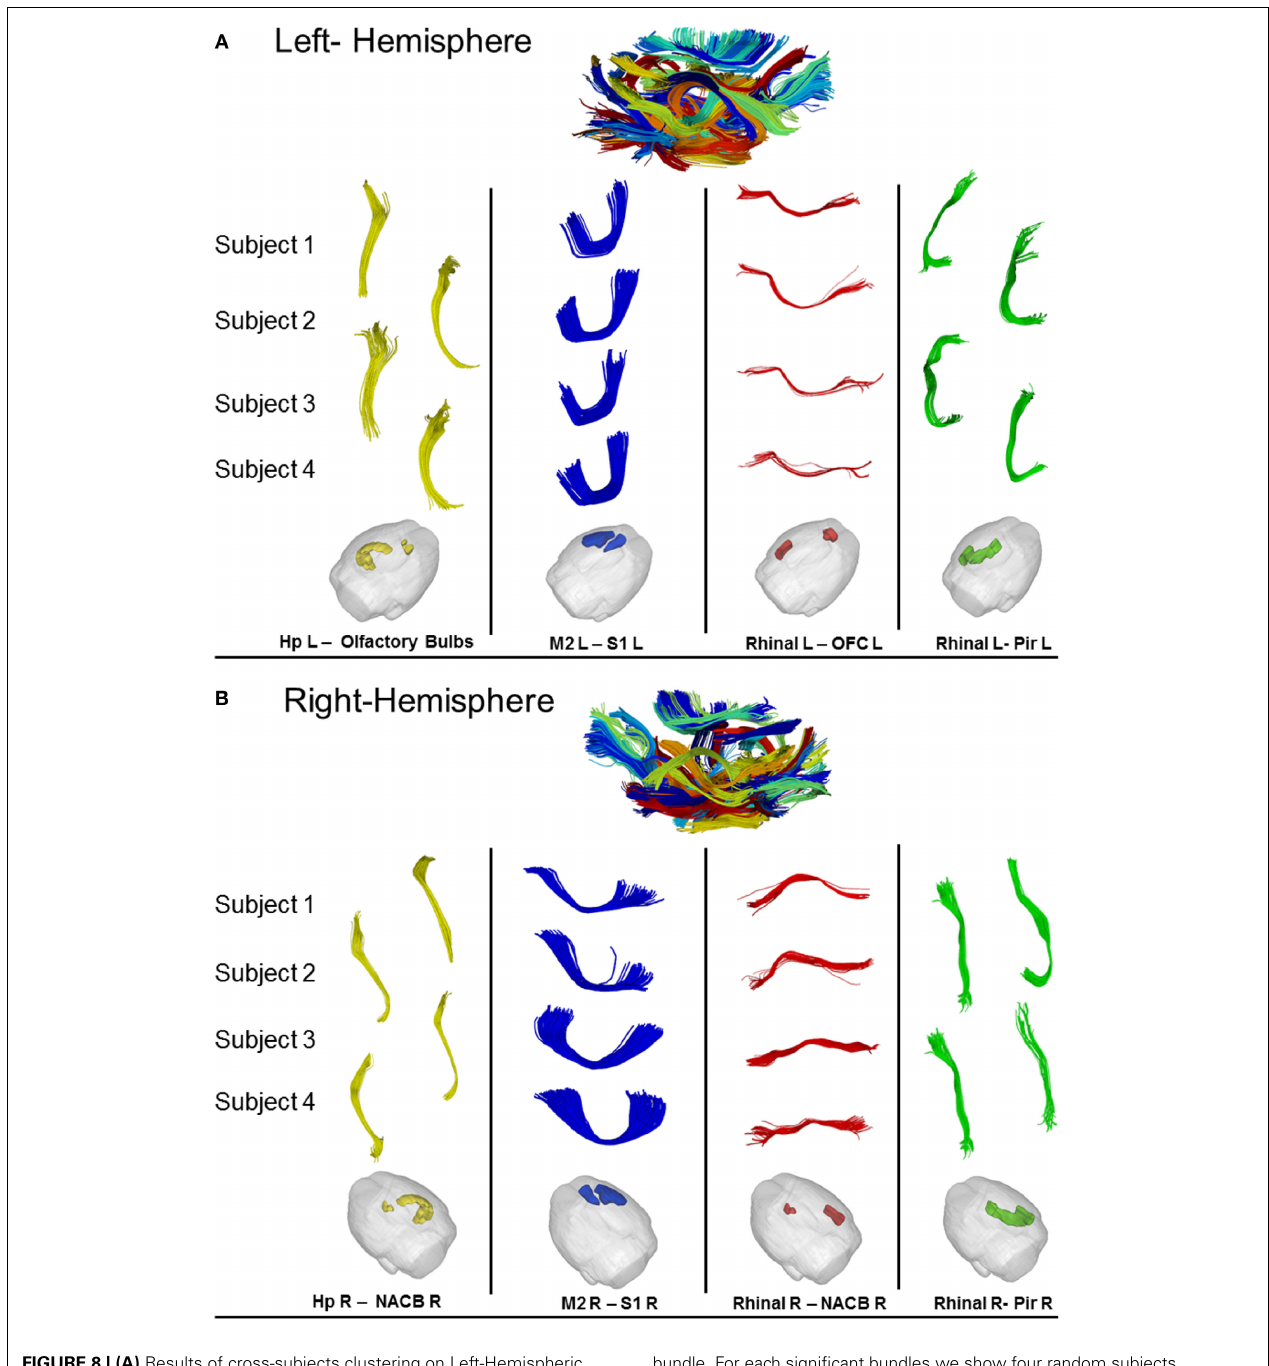
bundle. For each significant bundles we show four random subjects. Hp = Hyppocampus, S1 = Somato-Sensory Cortex, M2 = Motor Cortex, NACB = Nucleus Accumbens, Pir = Piriform Cortex, Rhinal = Rhinal Cortex, OFC = Orbitofrontal